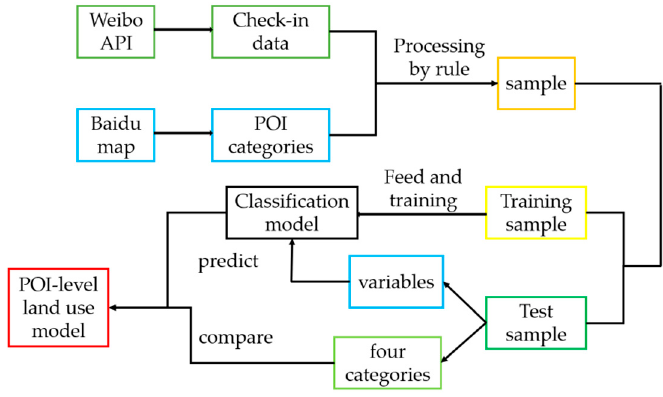
Figure 4. The workflow of the method.